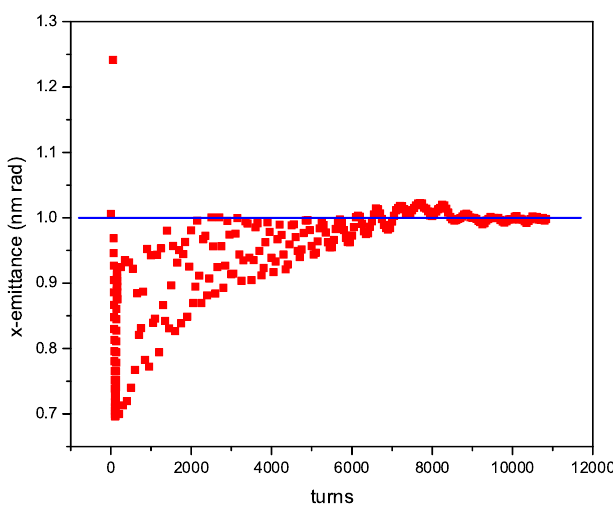
FIG. 6. (Color) Simulated horizontal emittance variation with turn number. The blue lines indicate the natural (synchrotron) emittances. The laser pulse is matched to the synchronous particle.